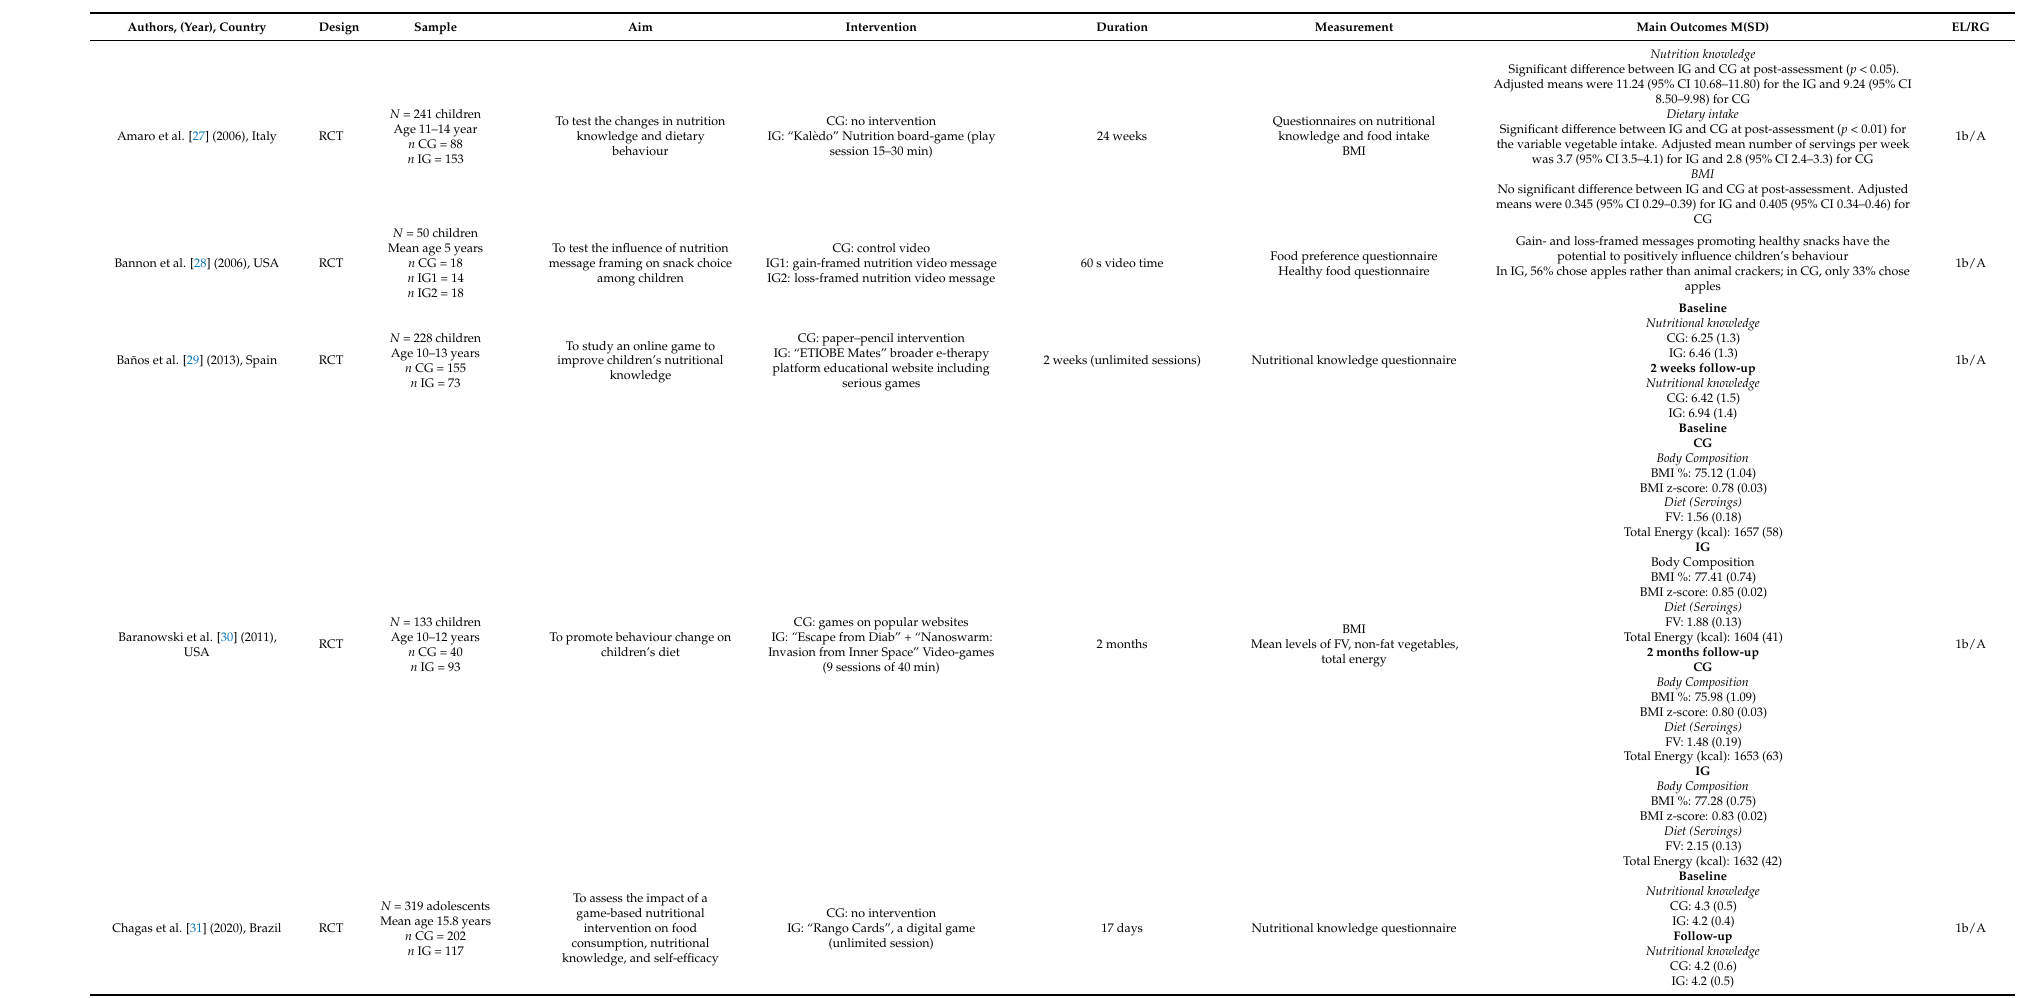
Table 1. Characteristics of the included studies (n =